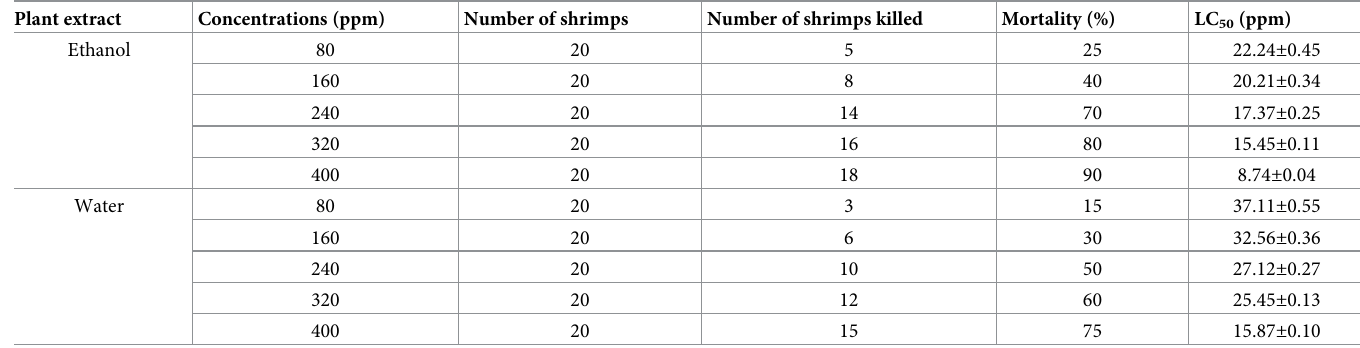
Table 2. Concentration dependent cytotoxic potential of crude ethanolic and aqueous extracts of M . piperita leaves against Brine shrimps nauplii. Plant extract